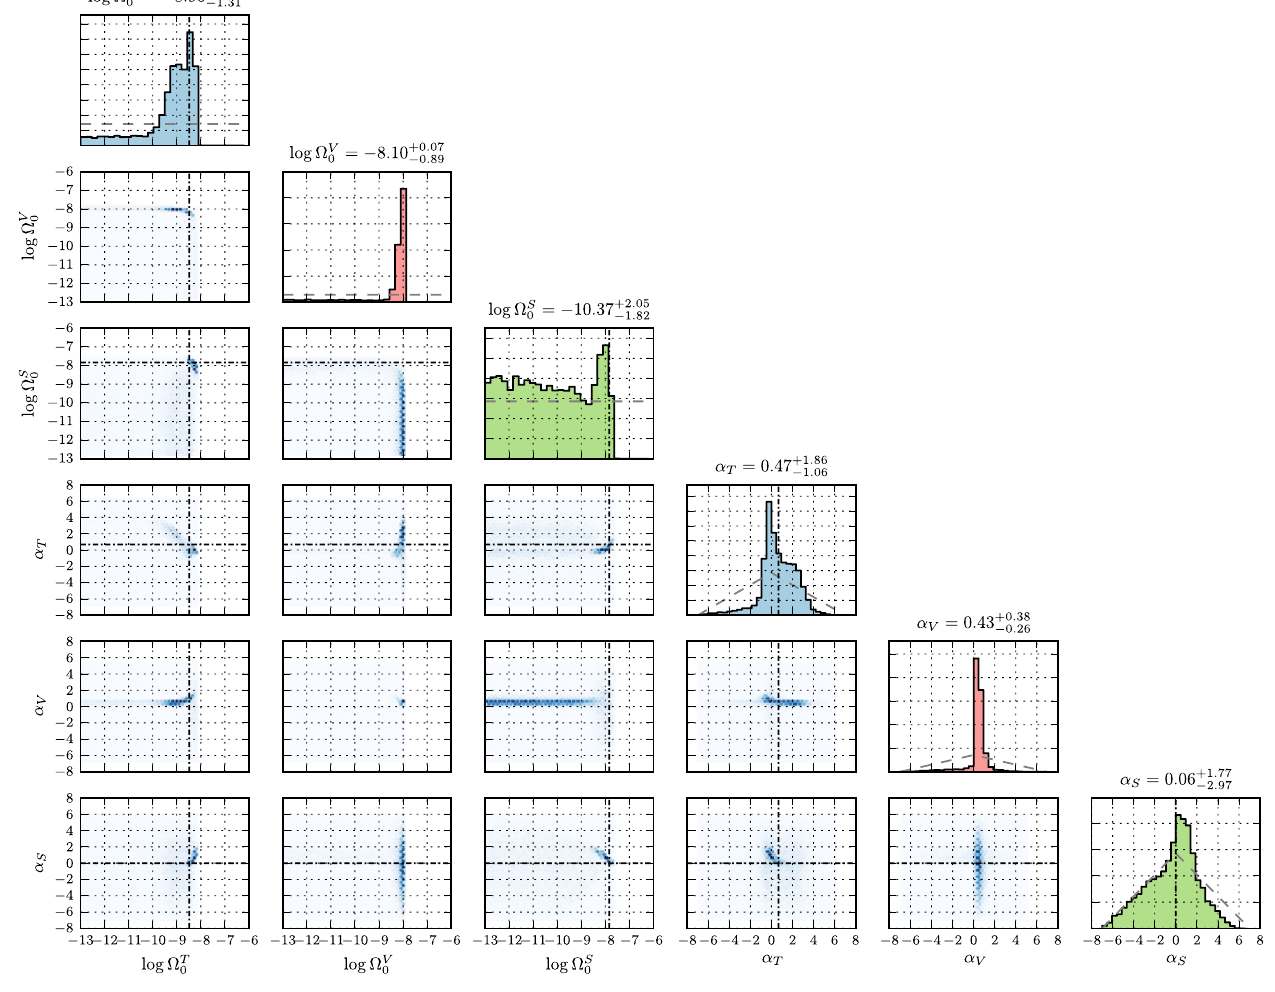
FIG. 14. As in Figs. 10 and 12, for a simulated observation of a mixed tensor and scalar background (case 3 in Table I). While the Ω T 0 and Ω S 0 posteriors are locally peaked about the true values, much of the observed energy is mistaken for vector polarizations. Thus, Advanced LIGO alone is unable to break the degeneracy between tensor, vector, and scalar amplitudes.